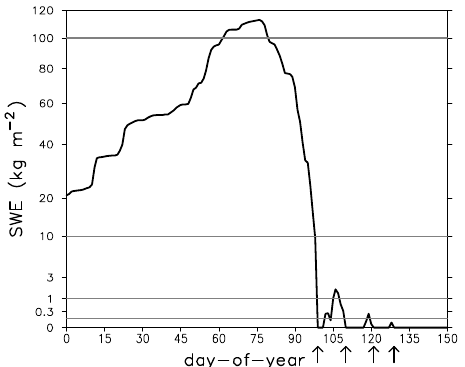
Figure 1. Time series of snow water equivalent (kgm − 2 ) in days 0– 150 of year 1988 for a grid cell in western Russia (60.6 ◦ N, 39.4 ◦ E) for one of the ECHAM5 runs included in the REF experiment (SWE plotted in a square root scale for a better viewing of small val- ues). The grey horizontal lines correspond to SWE values of 100, 10, 1 and 0.1kgm − 2 . The four arrows at days 99 (8 April), 110 (19 April), 121 (30 April) and 129 (8 May) indicate possible snow- off days (first day with SWE = 0 after a period with SWE > 0). The first snow-off day is employed in this paper for comparison with ob- servational data.